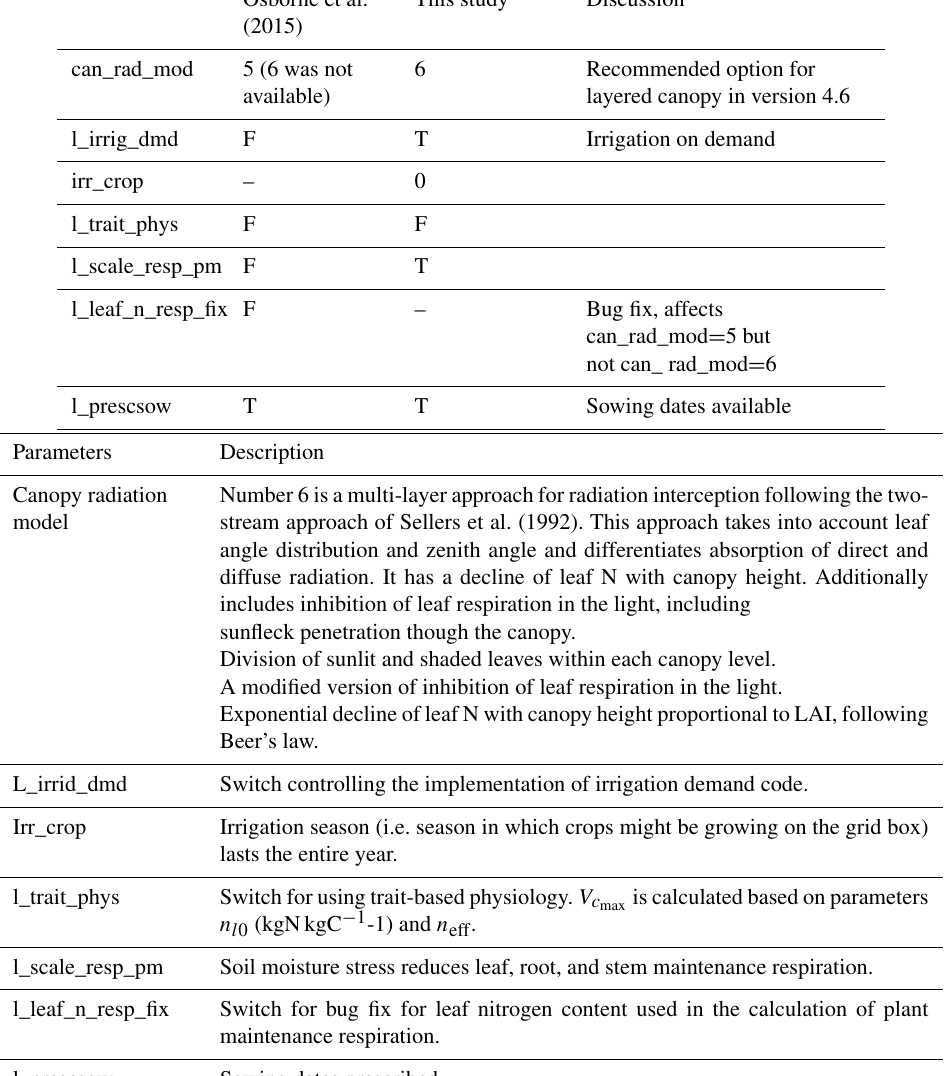
Osborne et al. This study (2015)